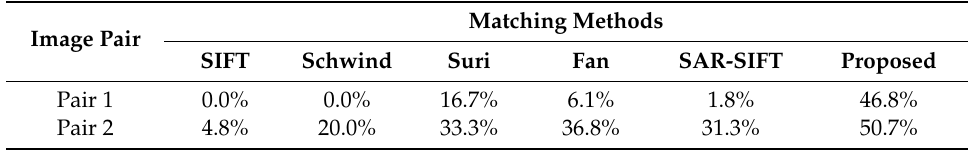
Table 9. MP values of each method for SAR and SAR images.